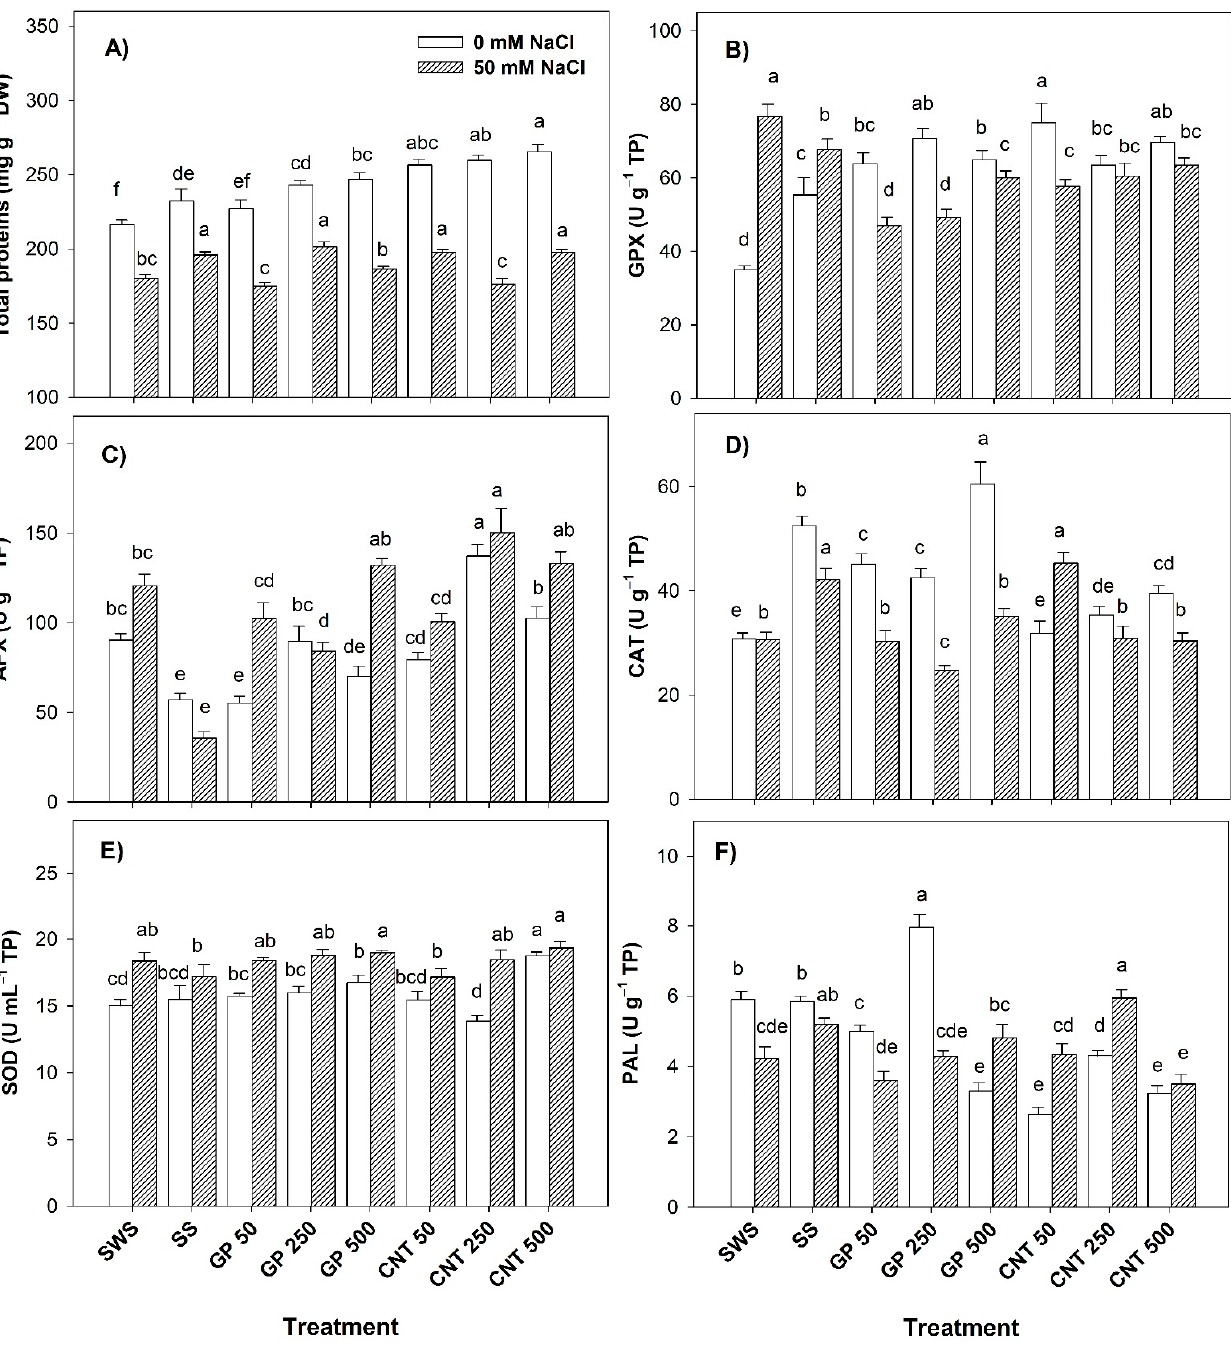
Figure 3. Total proteins and enzymatic activity in tomato leaves treated with carbon nanomaterials and salinity: ( A ) total proteins, ( B ) glutathione peroxidase (GPX), ( C ) ascorbate peroxidase (APX), ( D ) catalase (CAT), ( E ) superoxide dismutase (SOD), and ( F ) phenylalanine ammonia lyase (PAL). DW: dry weight; SWS: non-sonicated seeds; SS: sonicated seeds; GP: graphene; CNT: carbon nanotubes; 50, 250, and 500 represent the mg L − 1 applied of carbon nanomaterial. Different letters indicate a significant difference between treatments according to Fisher ( α = 0.05). n = 6 ± standard error. Under saline conditions, the proteins increased by 11.93% with GP 250 and 9.91% with CNT 50 and CNT 500 with respect to the non-sonicated control. With respect to the sonicated control, the protein content decreased with the addition of GP 50 (10.78%), GP 500 (4.77%), and CNT 250 (10.00%) (Figure 3A). The application of the treatments with